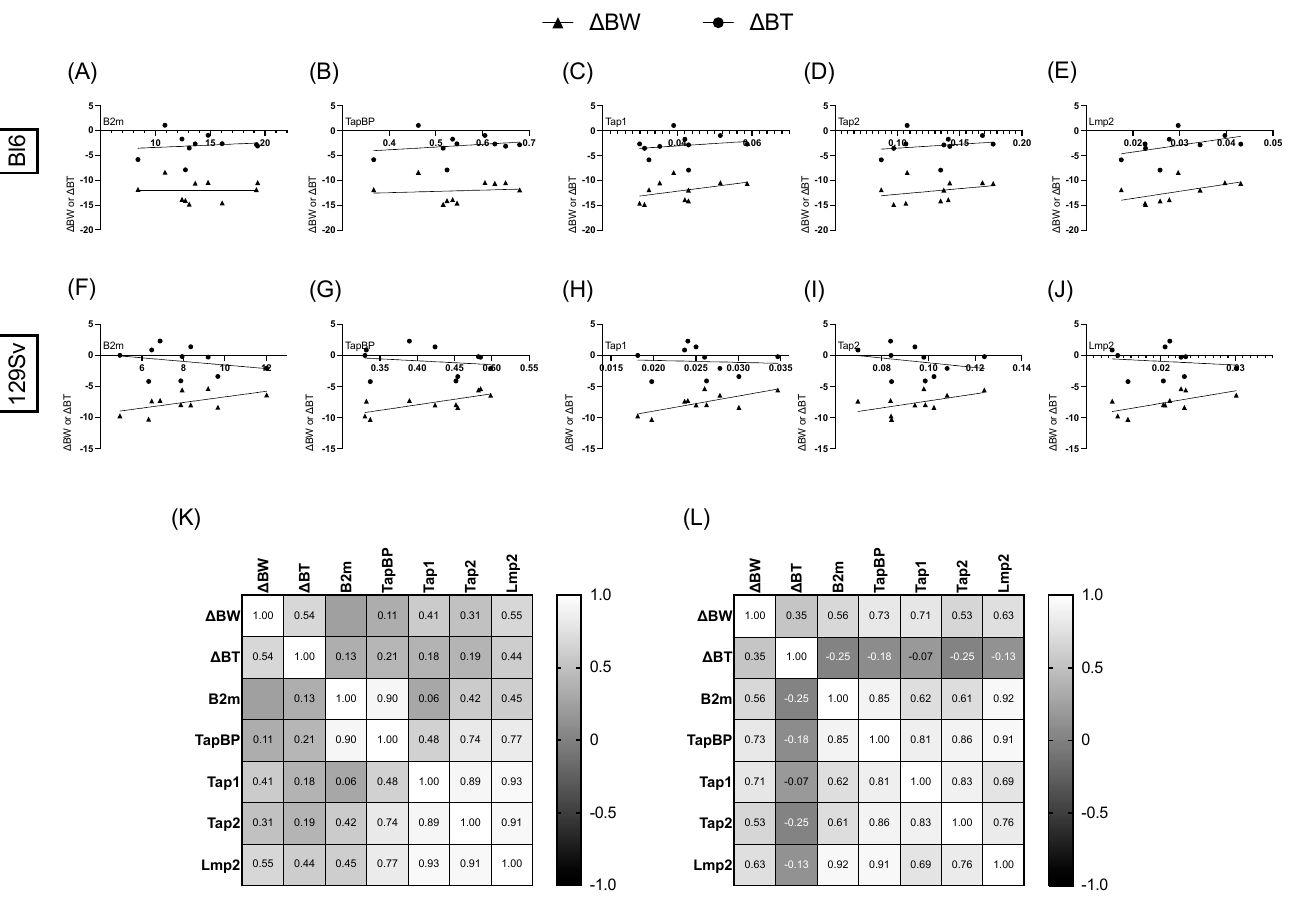
Figure 9. Correlation of MHC-I pathway gene expressions with bodyweight ( ∆ BW) and temperature ( ∆ BT) change in frontal cortex. Pearson correlation of ∆ BW and ∆ BT with β 2m ( A ), Tapbp ( B ), Tap1 ( C ), Tap2 ( D ), andI p2 ( E ) in Bl6 mice. Pearson correlation of ∆ BW and ∆ BT with β 2m ( F ), Tapbp ( G ), Tap1 ( H ), Tap2 ( I ), and Lmp2 ( J ) in 129Sv mice. Heatmap of Pearson correlation coefficients between Δ BW, Δ BT, and MHC-I-pathway gene expressions in Bl6 ( K ) and 129Sv ( L ) mice.